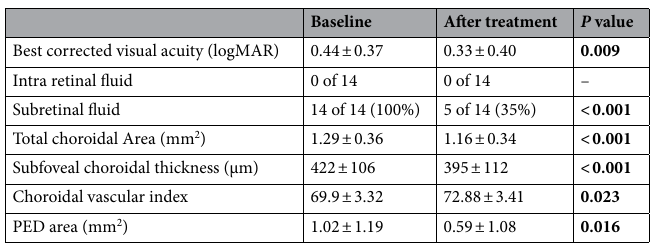
Association of age, sex, baseline TCA, SFCT, CVI, and PED area was investigated with alteration of BCVA after treatment in patients with aFIPED and vFIPED (Table 4). In eyes with aFIPED, baseline PED area and CVI was associated with vision improvement. In eyes with vFIPED, age showed to have negative association with vision improvement.